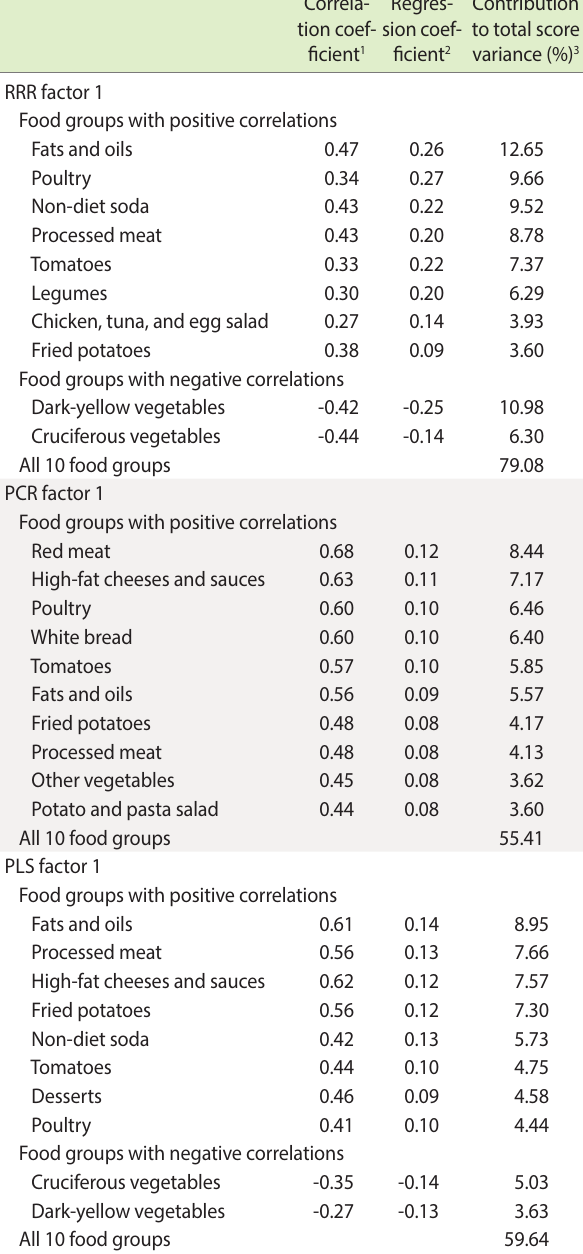
Table 4. The 10 food groups most strongly associated with the first dietary pattern obtained by RRR, PCR and PLS in 5,468 males and females from the MESA